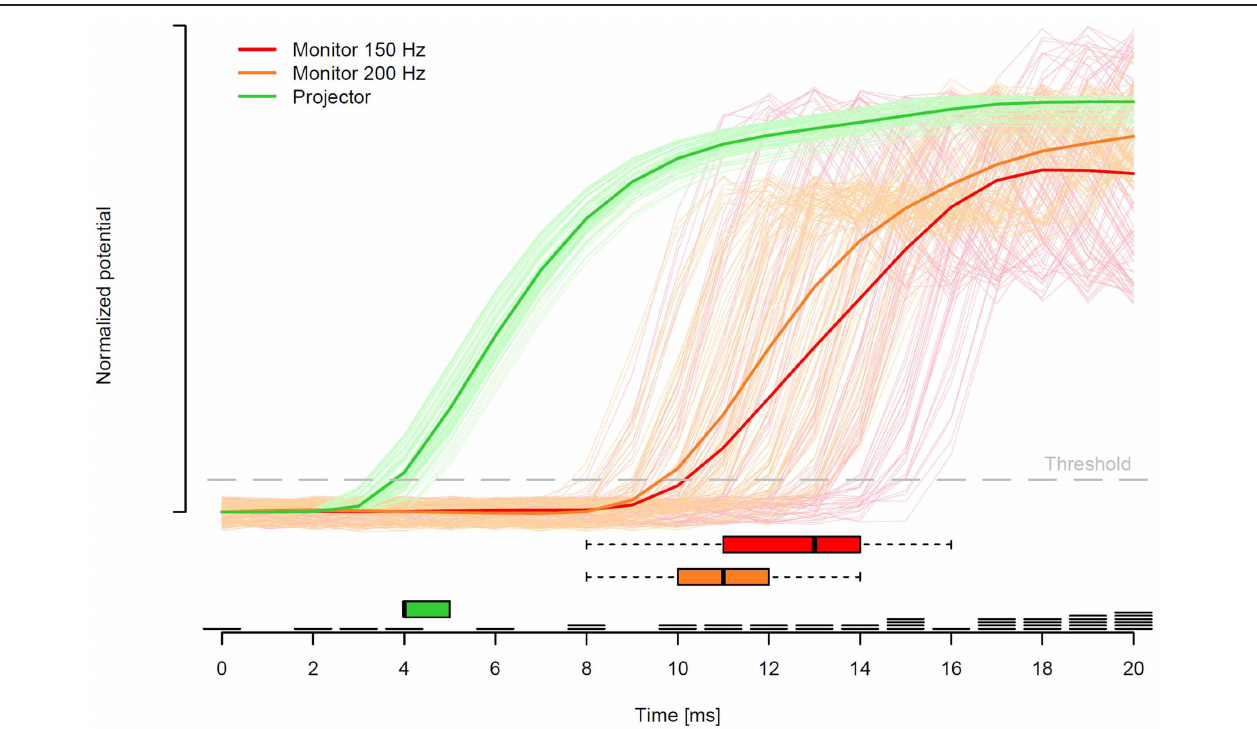
FIGURE 5 | Solid lines represent the mean of z -standardized voltage changes after baseline correction relative to the point in time when the invisible boundary was crossed. Lines in light green, orange, and red indicate each single trial of the projector setup, the monitor setup with 200Hz, and the monitor setup with 150Hz, respectively. An increase in standardized voltage indicates a display change measured by the photosensitive diode. Red, orange,